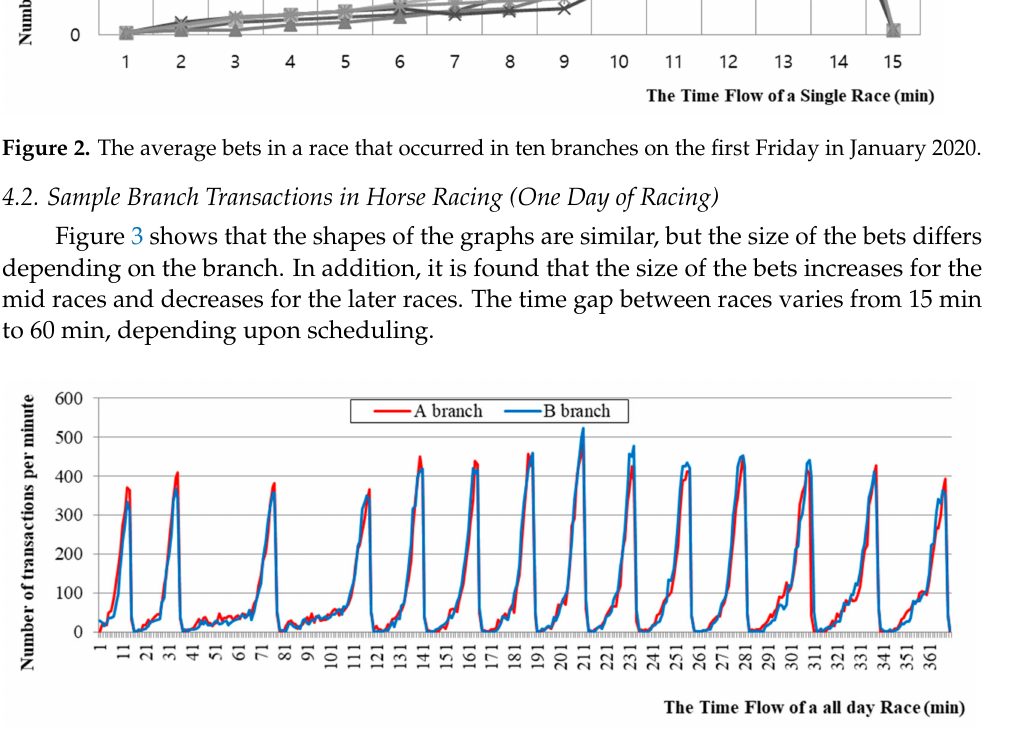
Figure 3. The differences in transactions between each race in two